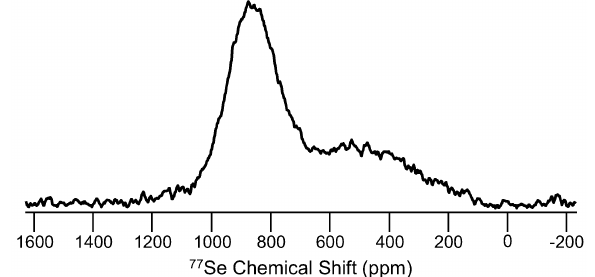
Figure 12. 77 Se MAS NMR spectrum of a binary germanium selenide glass (Ge 10 Se 90 ), with two distinct resonances assigned to Se bridging two Se atoms (left) and Se bridging one Se and one Ge atom (right) [85]. This room temperature spectrum was obtained at 4.7 T, using a 4-mm MAS NMR probe with modest sample spinning (10 kHz) and a recycle delay of 60 s, accounting for the lengthy 77 Se spin-lattice relaxation